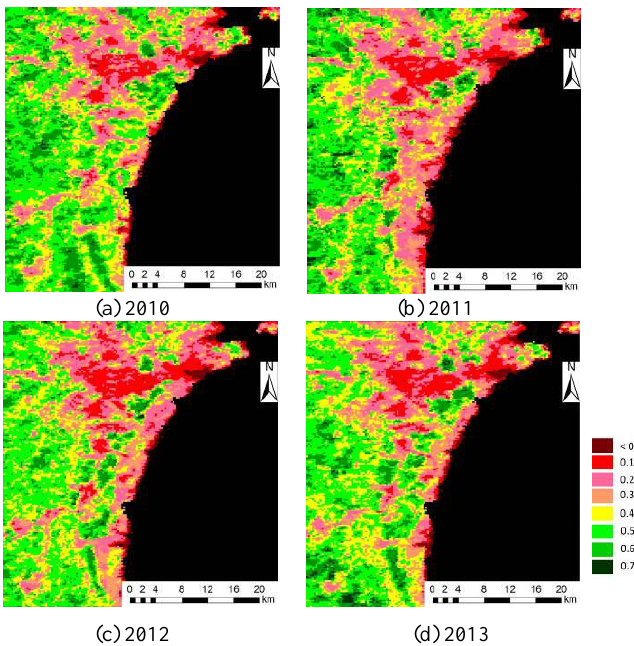
Figure 3(a), (b), (c), (d). NDVI images constructed